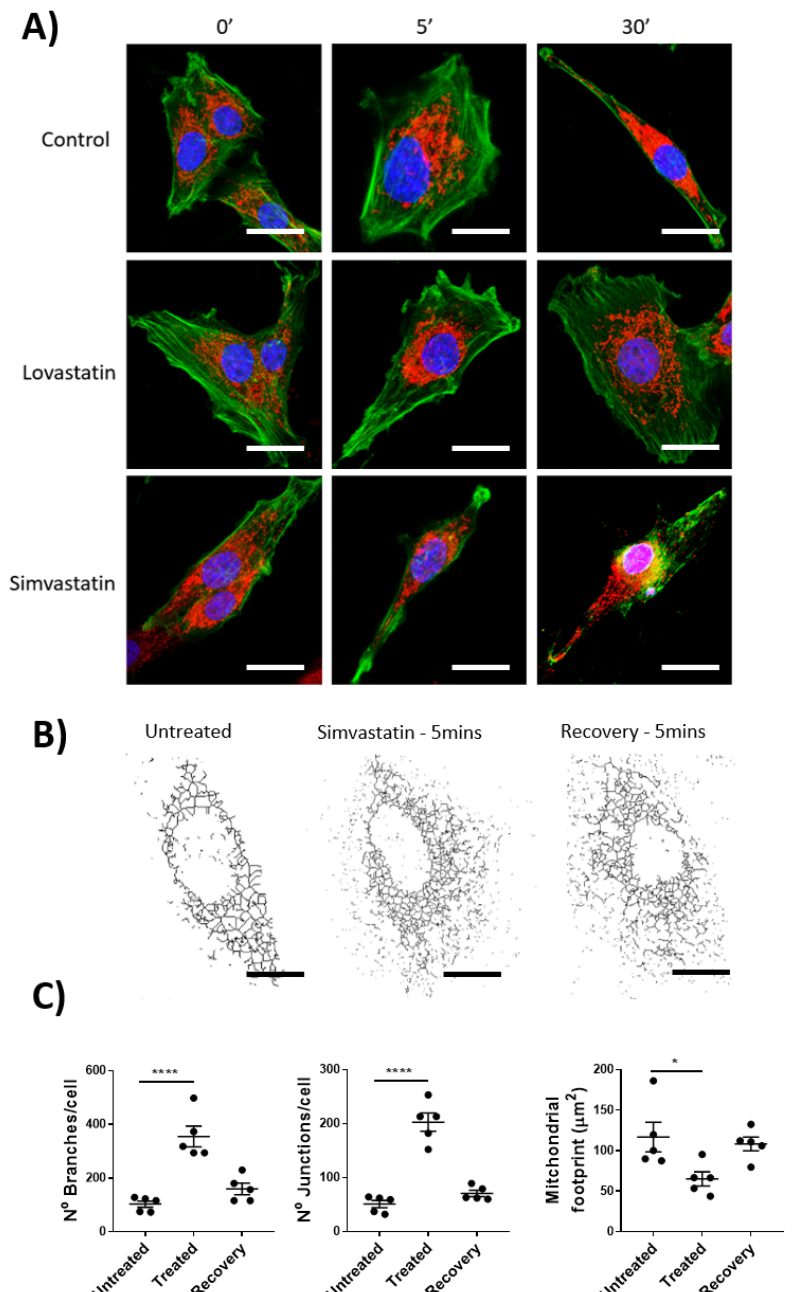
Figure 3. Mitochondrial network fission in mesenteric lymphatic smooth muscle cells of Simvastatin- treated rats. Primary LMCs were treated in vitro with 10 µ M of Lovastatin or Simvastatin for 5 or 30 min before being fixed and stained for the condition of the mitochondrial and actin cytoskeletal network using MitoTracker and Phalloidin, respectively. ( A ) Representative confocal images of indi- vidual cells and the effect of 5 or 30 min of treatment with each statin or control (Green: Phalloidin, Red: MitroTracker Red CMXRos). ( B ) Mitochondrial network structural analysis of a representa- tive effected cell treated with Simvastatin for 5 min (Treated) or wash-out for 30 min (Recovery). ( C ) Images were analyzed for Mitochondrial Branches, junctions, and overall mitochondrial footprint. Scale bar = 10 µ m. Data are presented as the average ± SEM of 5 randomly picked cells from n = 3 experiments. * p < 0.05, **** p < 0.0001 vs. untreated cells One-way ANOVA with Dunnet’s Multiple comparison